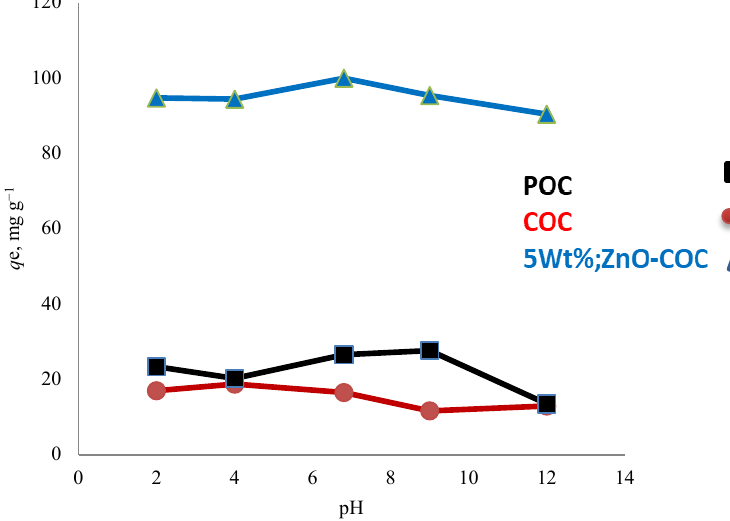
Fig. 7. Influence of pH on MB adsorption on (■) purified clay (●) calcined clay and (▲) impregnated clay ( m = 0.025 g; V = 50 mL; Ci = 50 mg L −1 ; T = 24